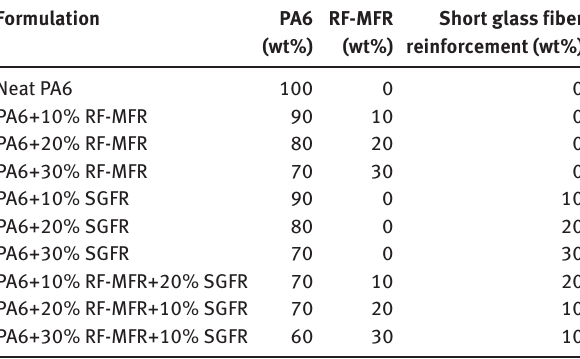
Figure 2 Variation of the elasticity modulus of PA6 with weight percent of reinforcement content.